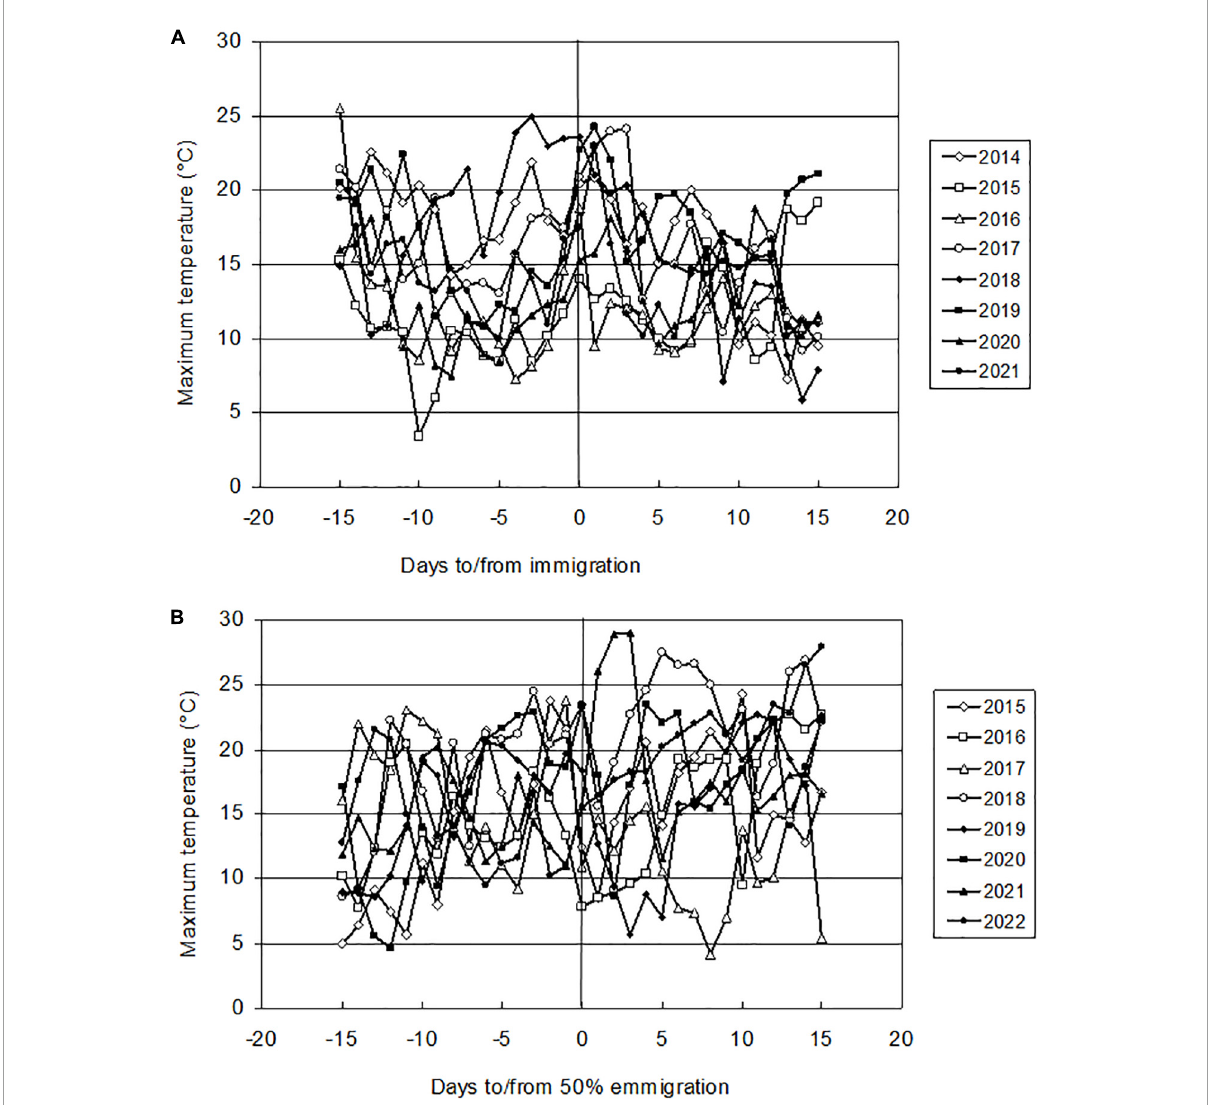
FIGURE5 Air temperatures (ordinate: daily maxima measured by the standard meteorological method) during the period of immigration and emigration from wintering grounds. (A) Immigration to the overwintering sites. Abscissa: 0–day of massive migration flight activity, negative values indicate days before this term, positive values indicate days after this term. (B) Emigration from artificial hibernaculum. Abscissa: 0–the day when 50% of individuals left the artificial hibernaculum (D 0 . 50 ), negative values mean days before D 0 . 50 , positive values mean days after D 0 . 50